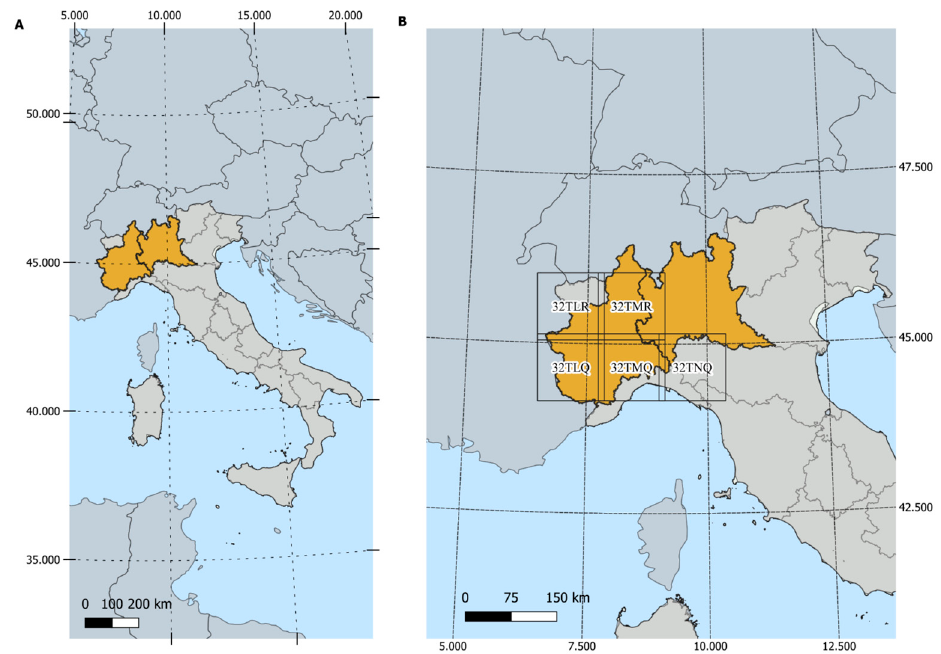
Figure 1. ( A ) Geographic location of the study area; ( B ) Extension of the five Sentinel-2 tiles used (32TLR, 32TMR, 32TLQ,